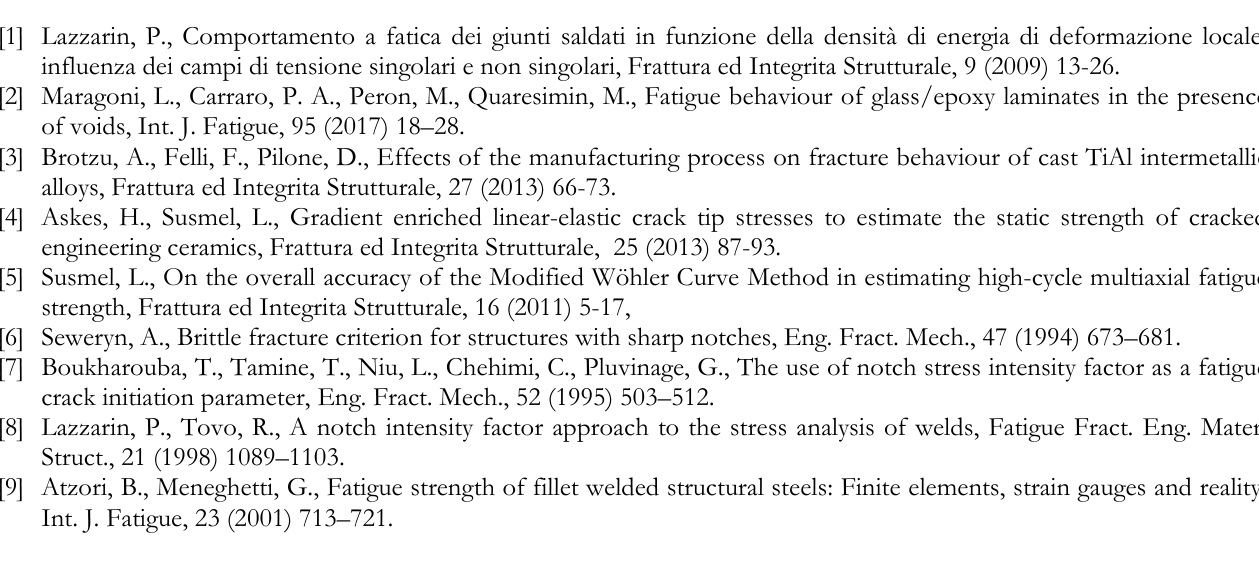
Table 5: Comparison between approximate methods for NSIFs evaluation of central tilted crack (2 α = 0°) in a plate of infinite